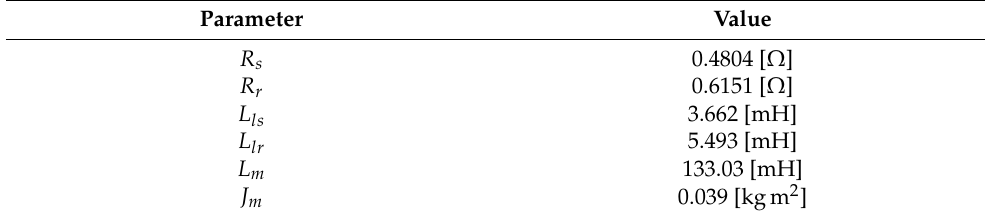
Table A1. Base Parameters Values Obtained from Manual